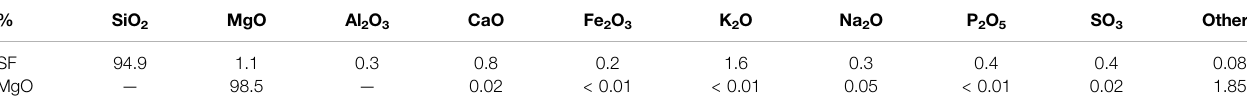
TABLE 1 | Chemical composition of the raw